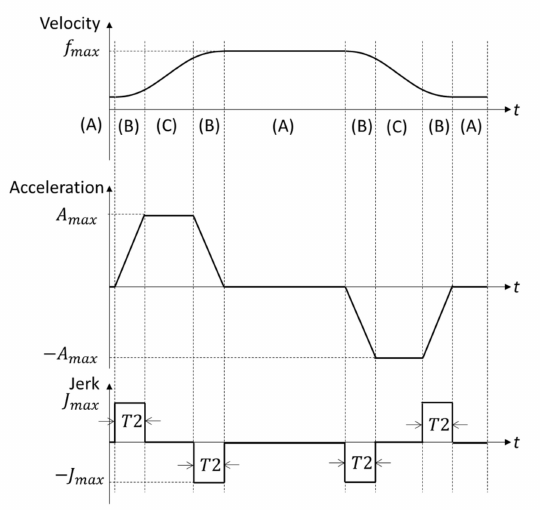
Figure 1. S-shaped acceleration/deceleration (Acc/Dec) control for a signal block.